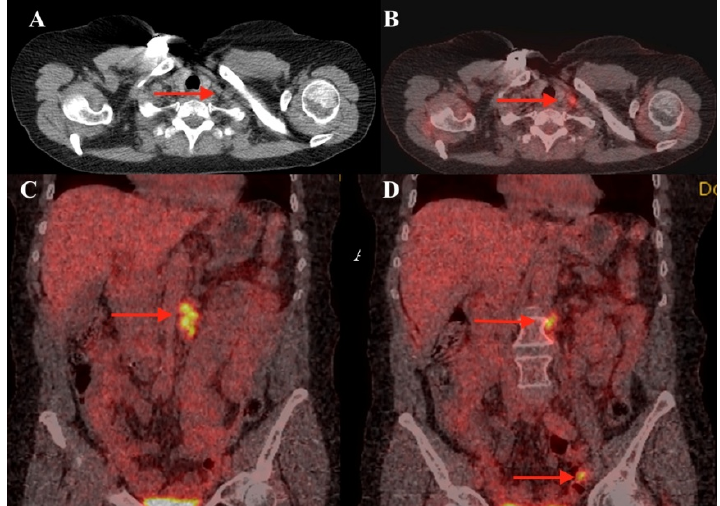
Figure 2. ( A ) F18-fluorodeoxyglucose positron emission tomography/computed tomography